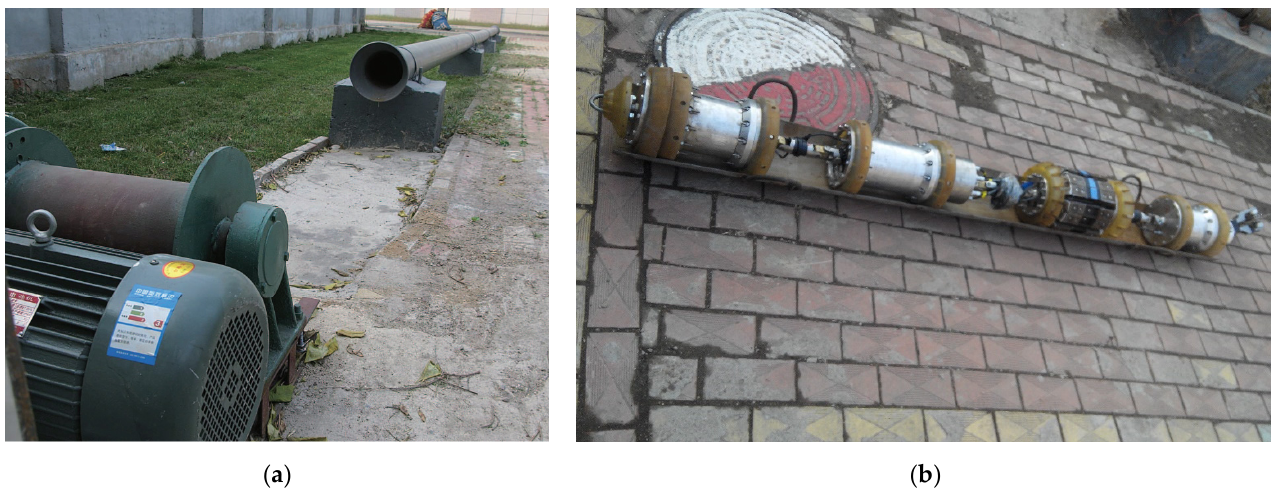
Figure 7. Photos of the test field and MFL internal detector. ( a ) The traction test field; ( b ) The MFL internal detector.